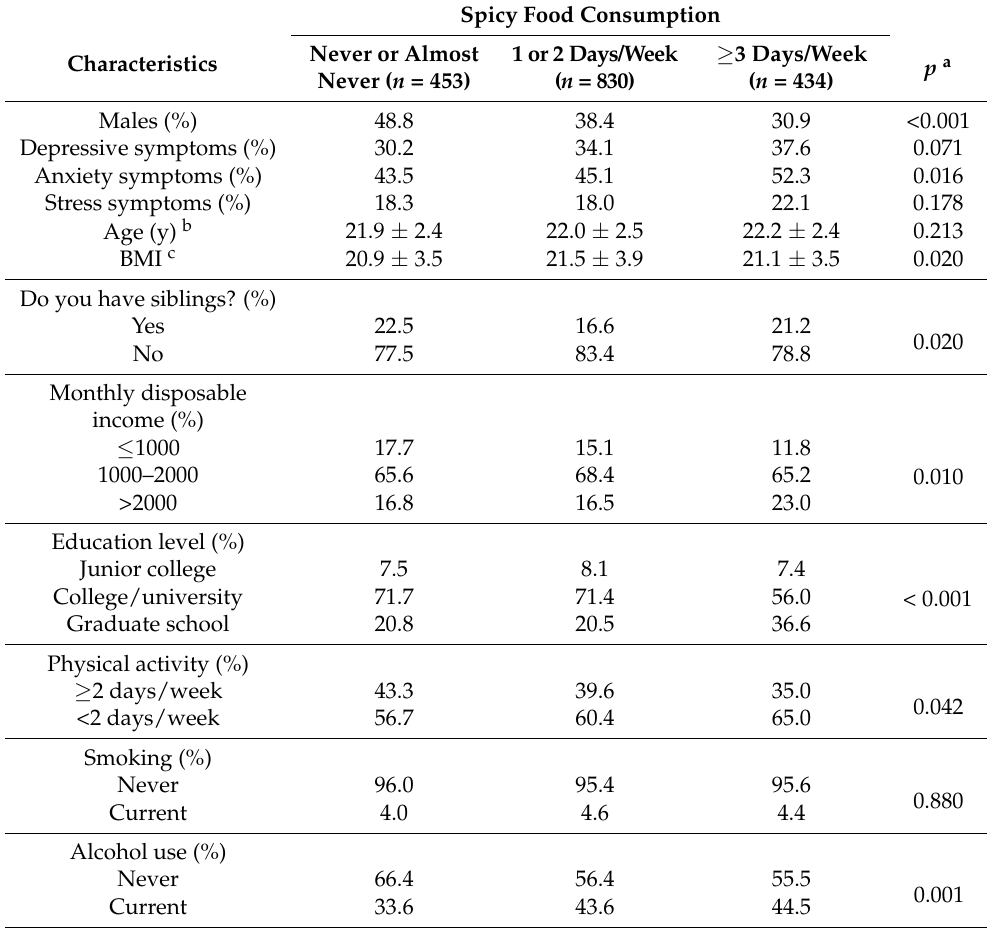
Table 1. Characteristics of the study subjects according to categories of spicy food consumption. Spicy Food